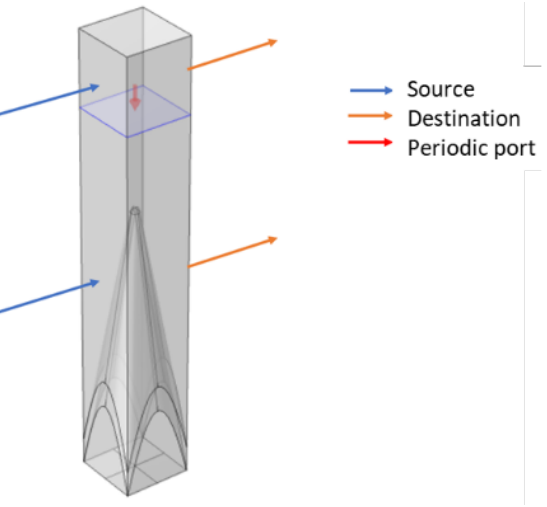
Figure 3. Rectangular computing unit model. As shown in Figure 4, the pattern has strong spatial symmetry. What this design emphasizes is the change of the two-dimensional pattern on the XOZ plane with array parameters. A two-dimensional far-field scattering model is then proposed, which is shown in Figure 5. The method of building a two-dimensional model uses a certain cross section to study the scattering field. After verification, each group of results needs to be calculated for about 30 seconds on a PC platform with a 4-core CPU and an 8-G memory.